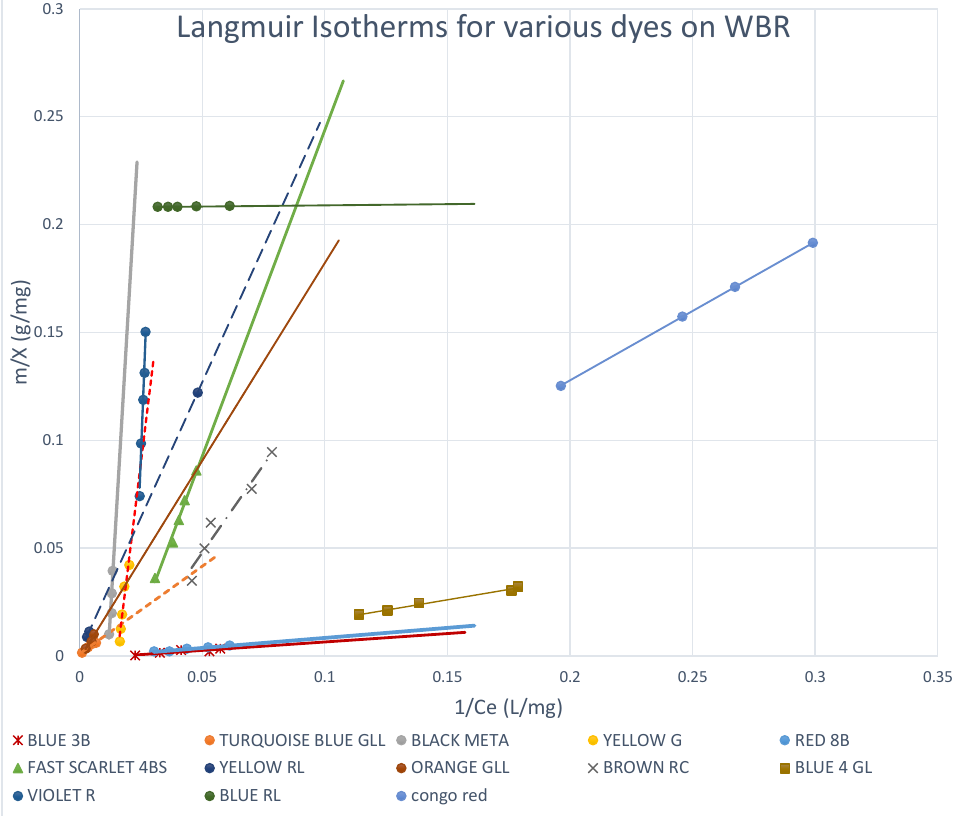
Figure 14. Langmuir isotherms for various dyes on WBR.